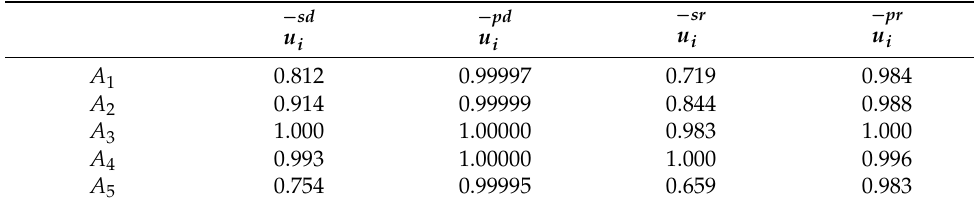
Table 19. The normalized values of four utility measures.